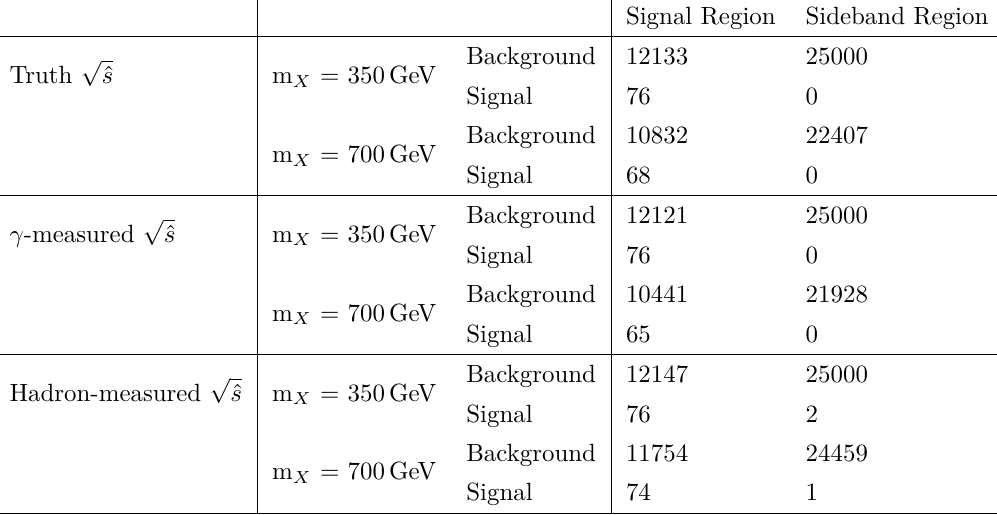
√ ˆ s measures, using the region definitions given in table 1, for an Table 2. Training yields for all example signal injection corresponding to a 1.0 σ